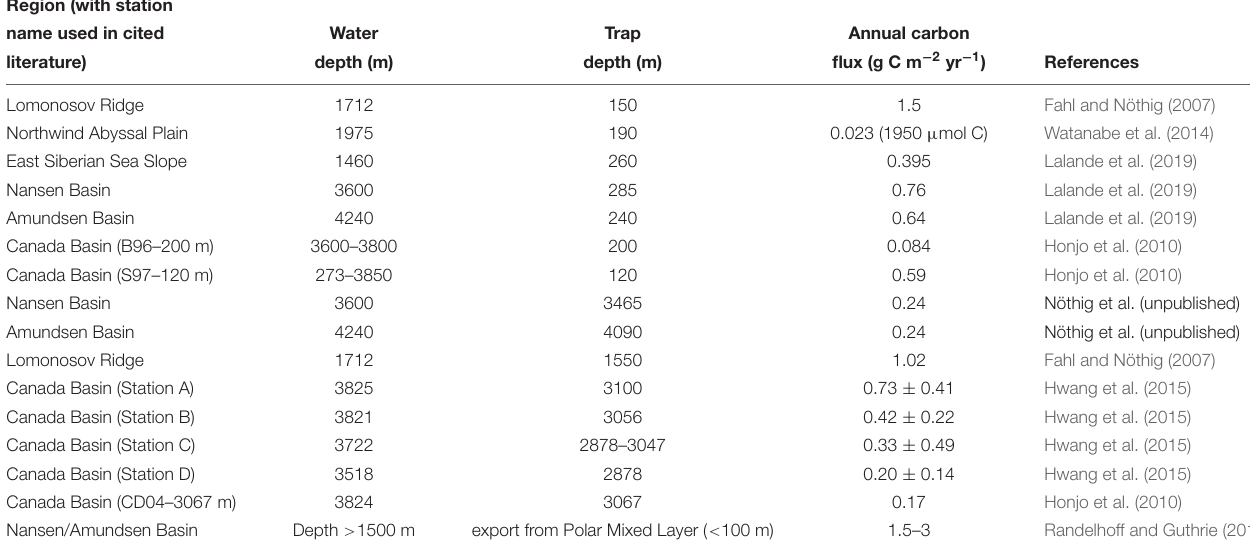
TABLE 4 | Annual estimates of the vertical carbon flux in the Arctic Ocean basins. Region (with